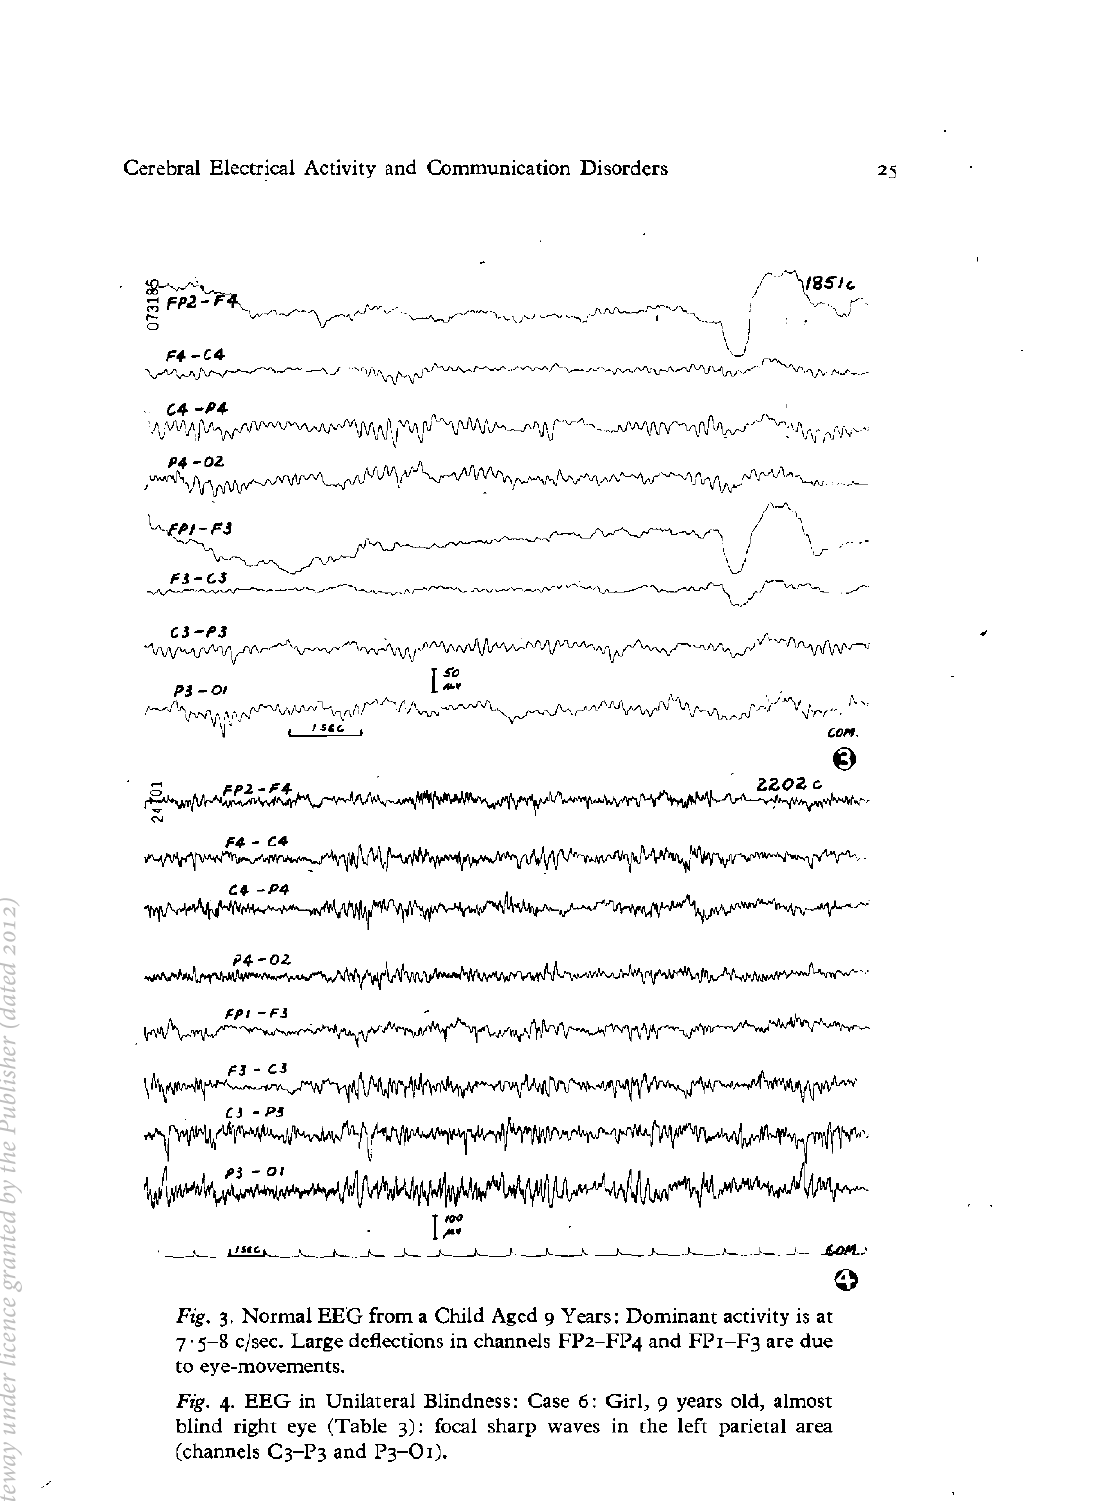
Fig. 3. Normal EEG from a Child Aged 9 Years: Dominant activity is at 7 • 5-8 c/sec. Large deflections in channels FP2-FP4 and FP1-F3 are due to eye-movements. Fig. 4. EEG in Unilateral Blindness: Case 6: Girl, 9 years old, almost blind right eye (Table 3): focal sharp waves in the left parietal area (channels C3-P3 and